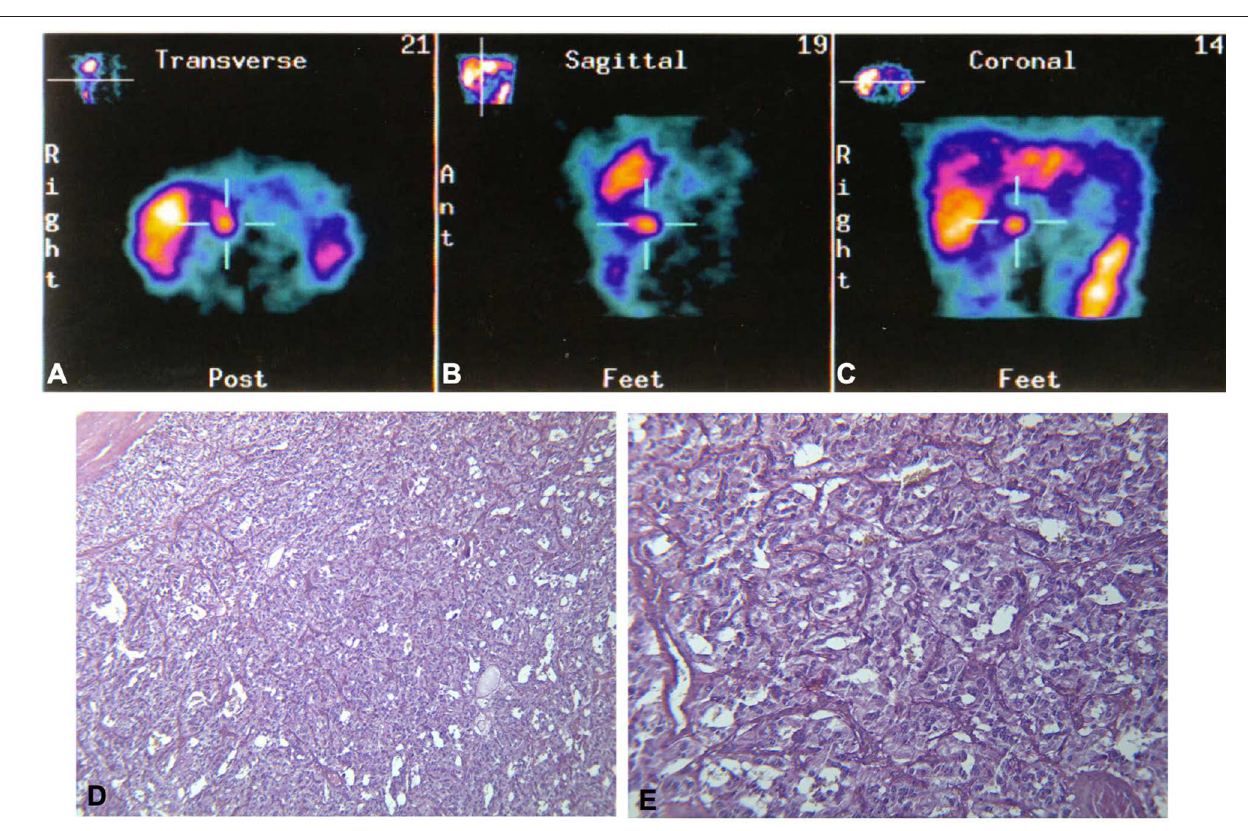
18, 20, 25, and 27 mm that were enclosed in a thin capsule with a reddish-tan surface and having multiple hemorrhagic areas. Histologically, spindle cells were found in 30% of the neoplasm, with prominent nucleoli. The nodules were strongly